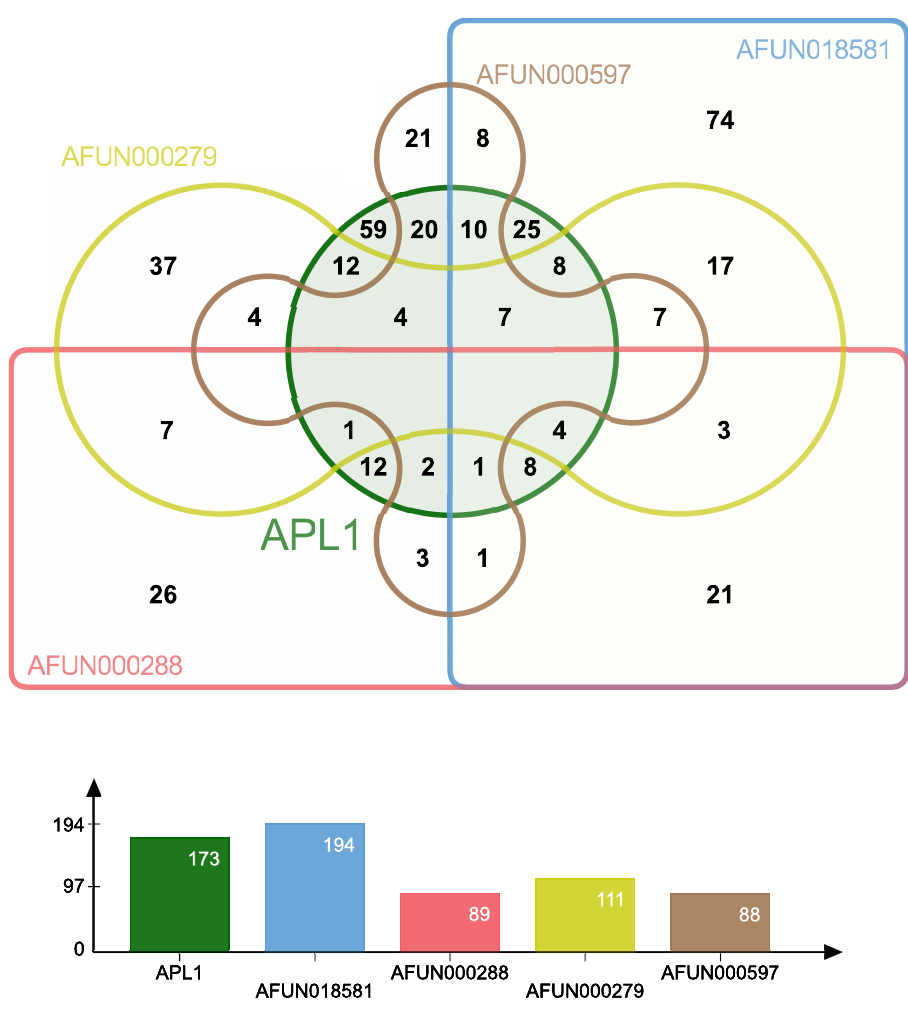
Figure 4. Venn diagram and bar chart of shared polymorphisms for APL1 paralogues. Polymor- phisms that occur in the same alignment position of the same reference and alternate alleles between paralogues after removal of discordant read mapping. Each gene is labelled with a different color, total number of shared positions per gene is given in the bar chart